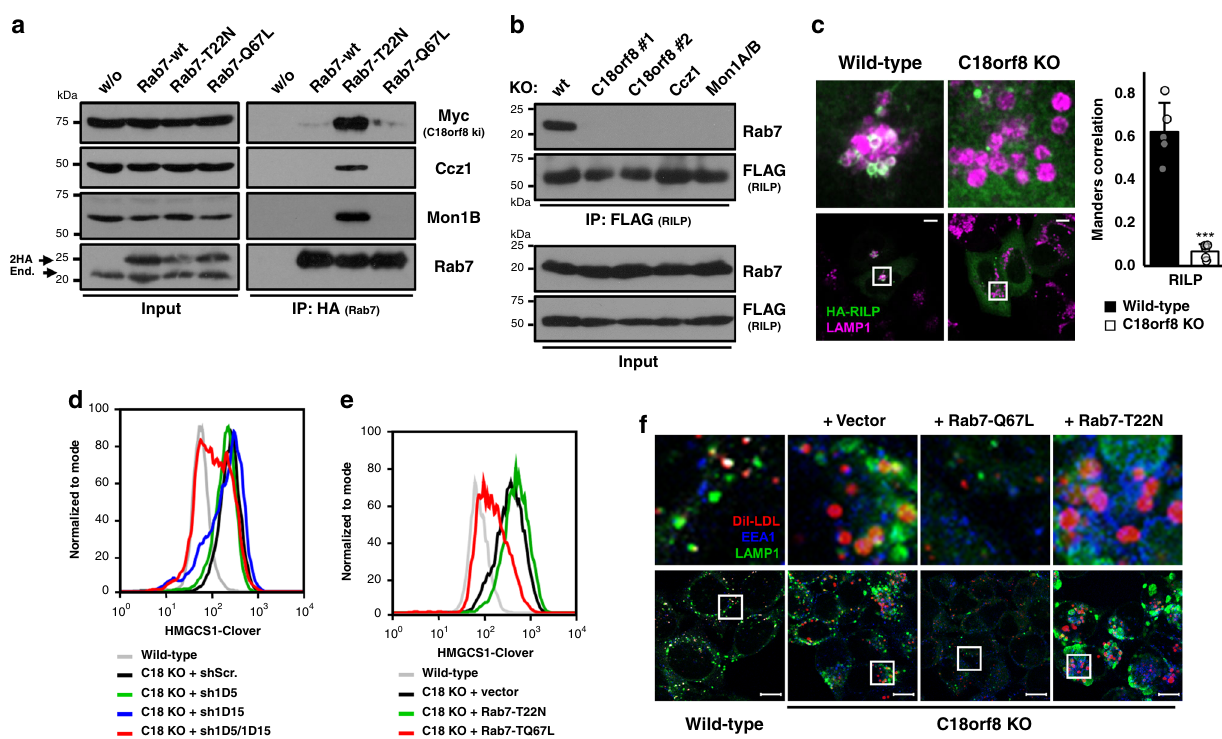
Fig. 6 The trimeric Ccz1-Mon1-C18orf8 (MCC) complex activates mammalian Rab7. a The MCC complex binds an inactive Rab7 (T22N). Immune precipitations of 2xHA-tagged wild-type, T22N or Q67L Rab7 from C18orf8-3xMyc knock-in cells, were analysed by immunoblot using Myc-, Ccz1- and Mon1B-speci fi c antibodies (2 independent experimental replicates, see also Supplementary Fig. 6a). b , c C18orf8 -, Ccz1 - and Mon1A/B -de fi cient cells lack activation-dependent recruitment of Rab7 effectors. b Immune precipitations of 3xFLAG-RILP from wild-type, C18orf8 -, Ccz1 - or Mon1A/B -de fi cient cells were analysed by immunoblotting for endogenous Rab7 (two independent experimental replicates). c Wild-type and C18orf8 -de fi cient cells were transfected with HA-RILP or ORP1L (Supplementary Fig. 7a) and stained intracellularly for HA (green) and LAMP1 (magenta). Mander ’ s correlation was determined for n = 5 fi elds per condition from two independent experiments. Error bars re fl ect standard deviation (two-sided unpaired t -test, p = 2.1 × 10 − 5 , *** p < 0.001). d – f Cholesterol and traf fi cking defects in C18orf8 -de fi cient cells can be rescued by knockdown of Rab7GAPs or expression of a constitutively active Rab7 (Q67L). d HMGCS1-Clover expression was determined at day 8 after transduction of C18orf8 -de fi cient cells with shRNAs against TBC1D5 (green), TBC1D15 (blue) or both (red). e-f C18orf8 -de fi cient cells were transduced with 2xHA-tagged Rab7-T22N (green), -Q67L (red) or an empty vector (black) and either ( e ) analysed at day 10 by fl ow cytometry for HMGCS1-Clover expression (two independent experimental replicates, see also Supplementary Fig 6b), or f pulse-labelled with Dil-LDL (red), incubated for 3 h and stained intracellularly for LAMP1 (green) and EEA1 (blue). Representative images are shown from 5 fi elds per condition. Scale bars = 10 µ decreases, and the NPC1 inhibitor U18666A, which increases lysosomal cholesterol levels (Fig. 8g).